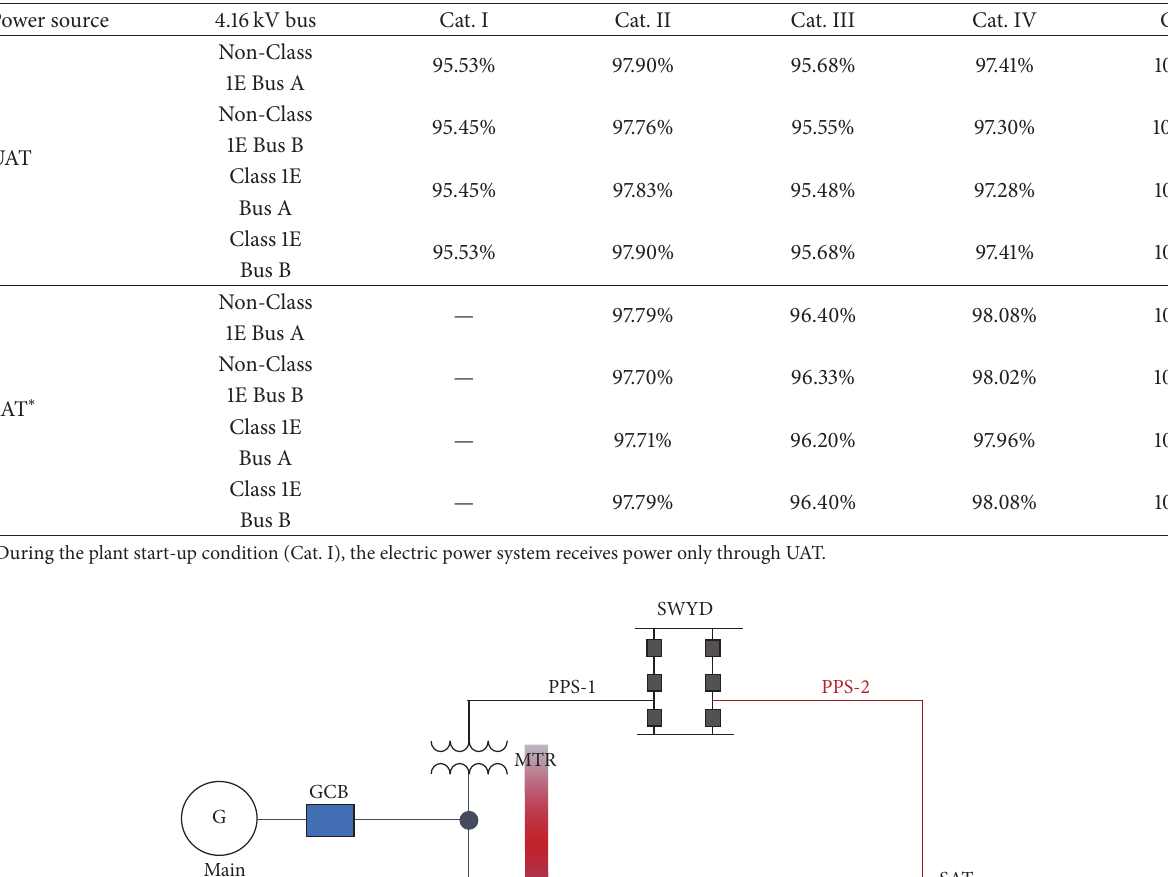
Table 1: The result of load flow analysis for APR1400.